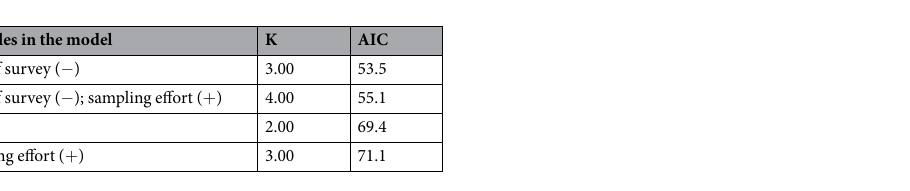
Table 2. Candidate N -mixture models on factors determining the detection probability of Aeolian lizards. Signs after variable names indicate the sign of regression coefficients. Models are ranked on the basis of their AIC values. K: number of parameters in the